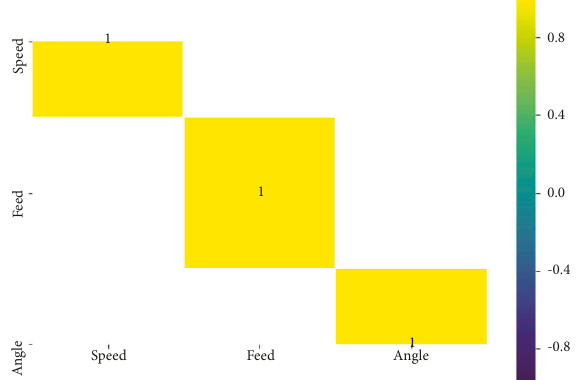
Figure 3: Univariate analysis of the feature parameters.